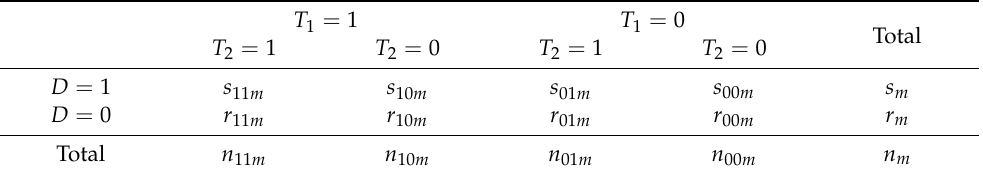
Table 1. Observed frequencies for X = X m